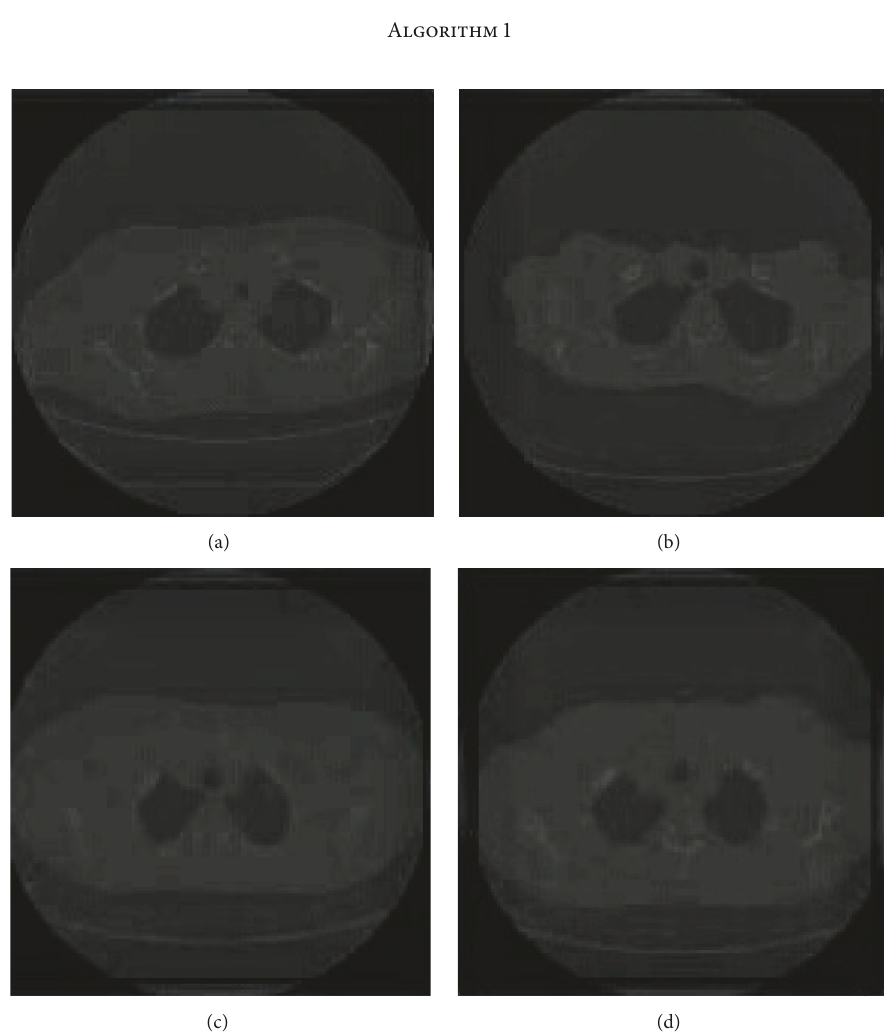
Figure 3: CT images of patients with emphysema condition as (a) minimal or no emphysema; (b) centrilobular emphysema; (c) paraseptal emphysema; (d) panlobular